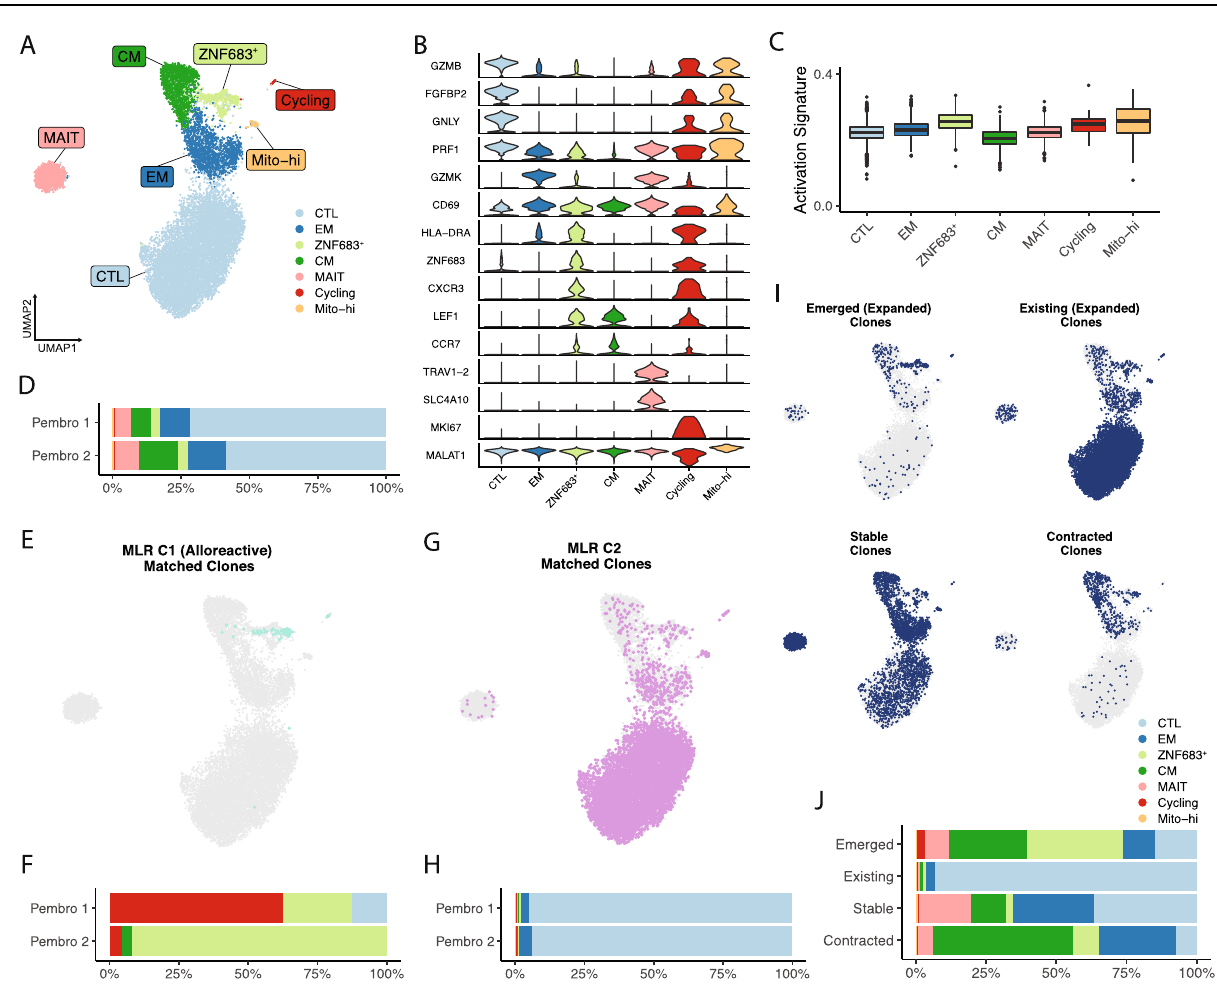
dots). H Bar plot of the cluster distribution of MLR C2 matching clones across timepoints. I UMAPs highlighting clones expanded or contracted in blood. J Bar plot of the cluster distribution of clones expanded or contracted in the blood. Boxes in ( C ) denote the interquartile range, with the horizontal line at the median, and outlier cells are shown as